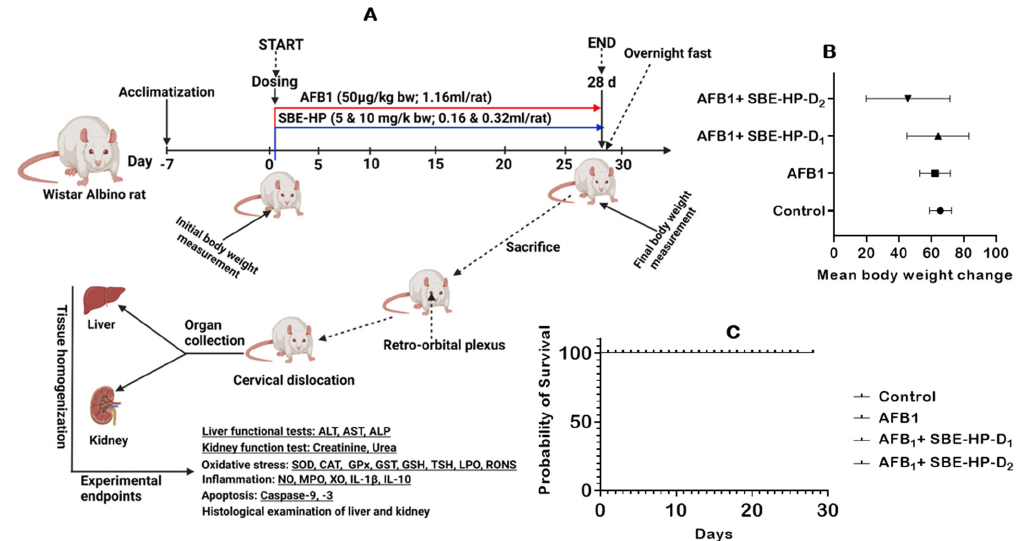
Figure 3. Experimental protocol of AFB 1 and API-rich hydrophobic fraction of S. bicolor extracts 28 consecutive days. ( A ) In vivo screening of the hepatoprotective effect of SBE-HP on AFB1-challenged adult male Wistar Albino rats for 28 consecutive days, ( B ) effect of SBE-HP on the mean body weight change of AFB1-treated treated, and ( C ) Kaplan-Meier curve of rats treated with SBE-HP and AFB 1 . Created by https://app.biorender.com/ (accessed on 8 July 2022).